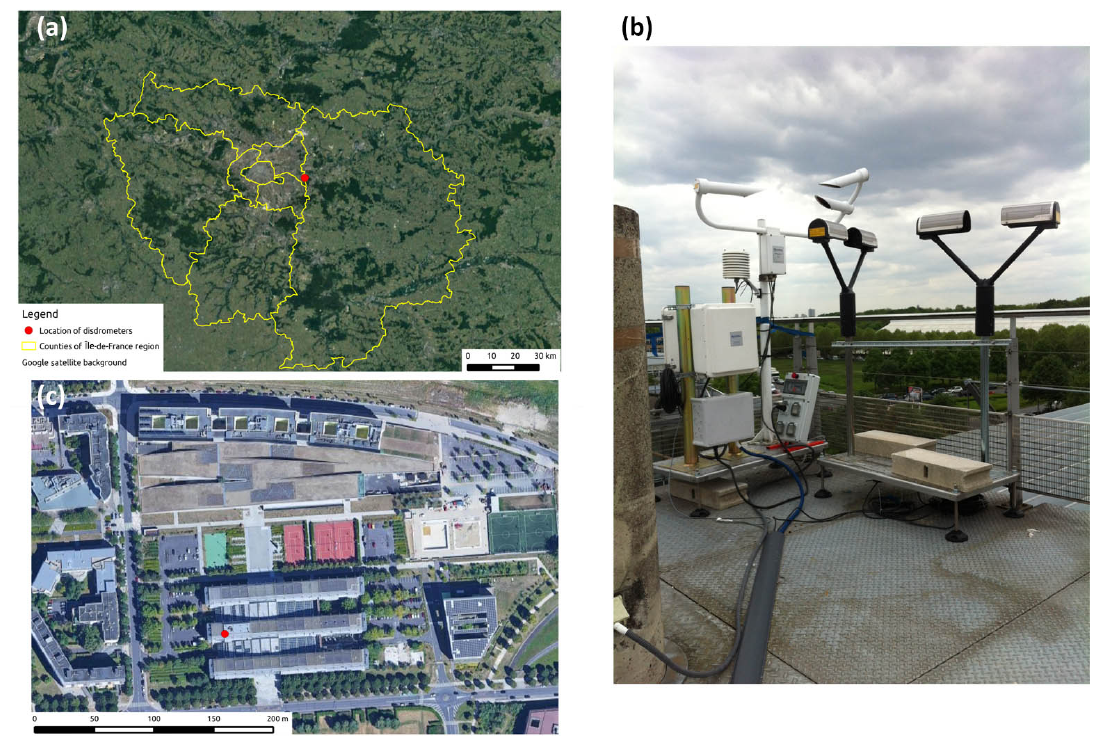
Figure 1. Location of the disdrometers in the Paris area (a) , on the roof of the Carnot building (b) and at the ENPC campus (c)